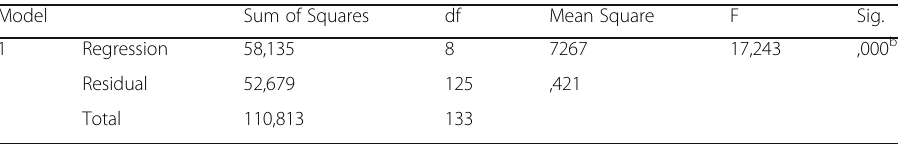
Table 20 ANOVA R3 a Model